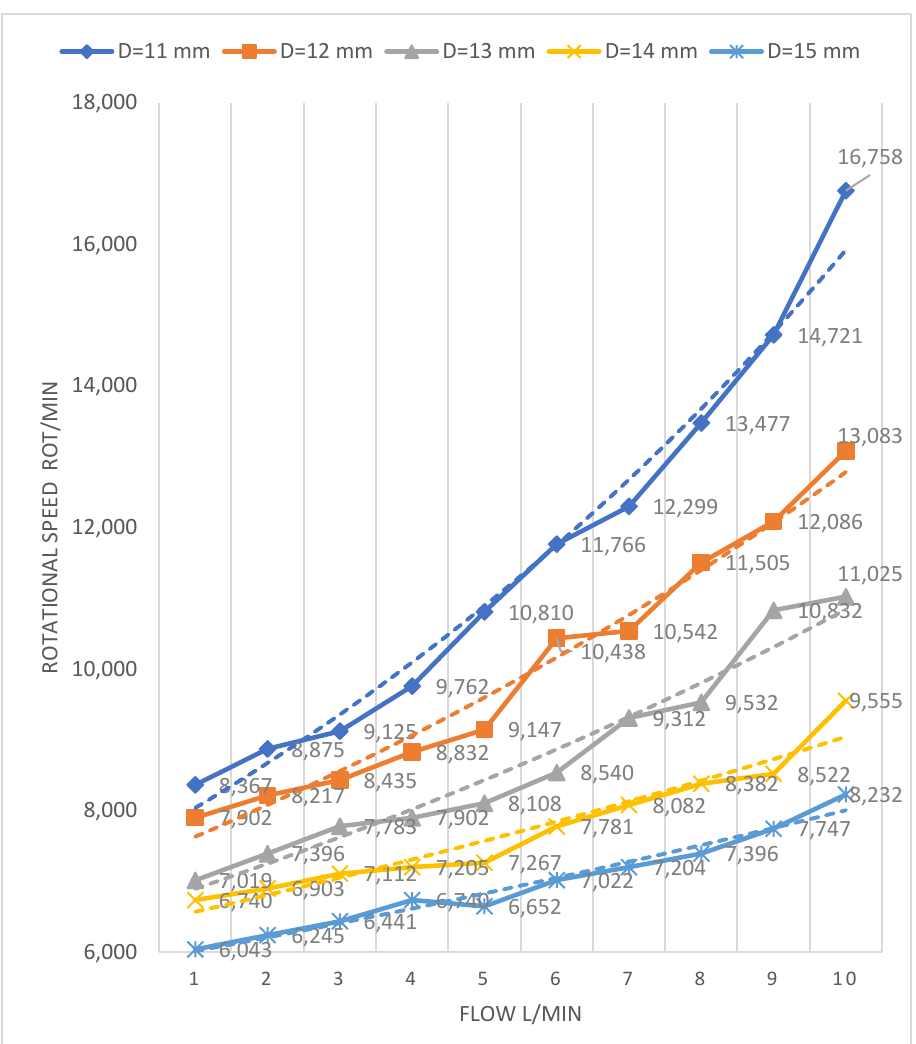
Figure 3. Graphical representation of the values of rotational speeds required for different pump diameters to provide different flow rates calculated by mathematical modeling and approximated on the Cordier diagram. D, diameter.